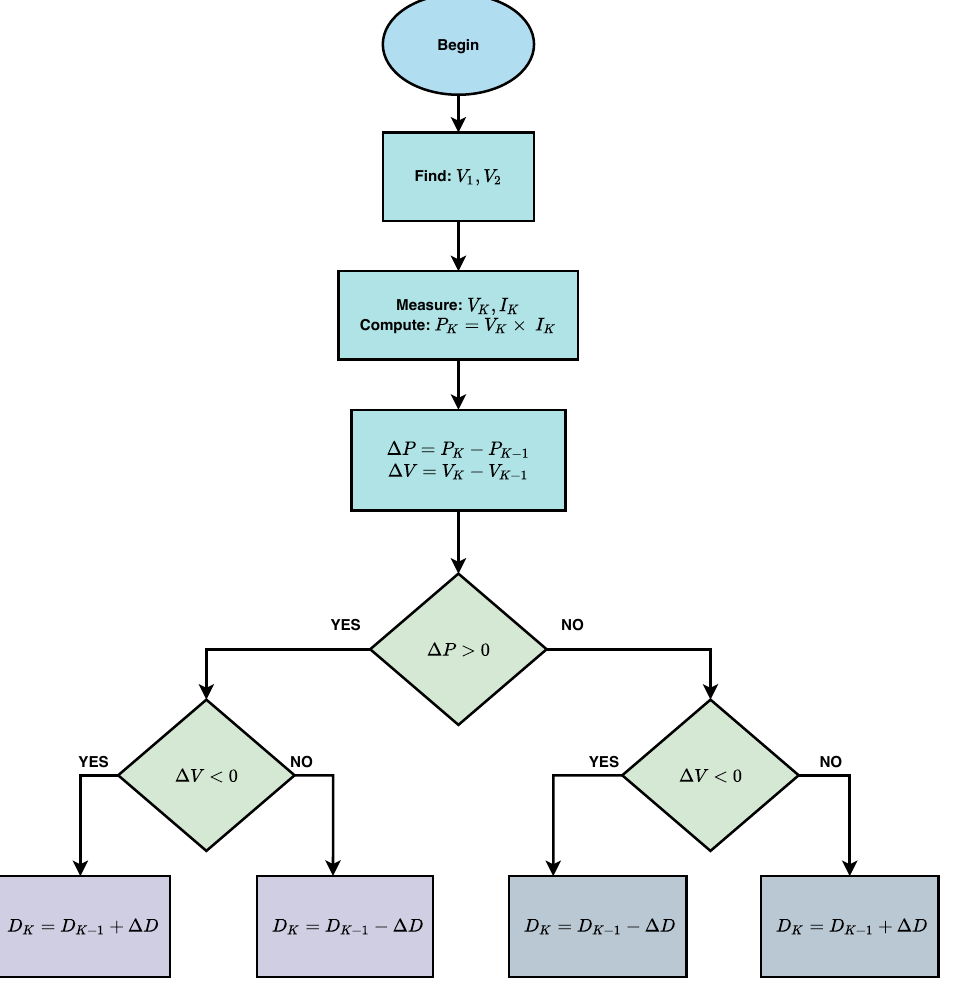
Figure 5. Flowchart of the conventional P&O